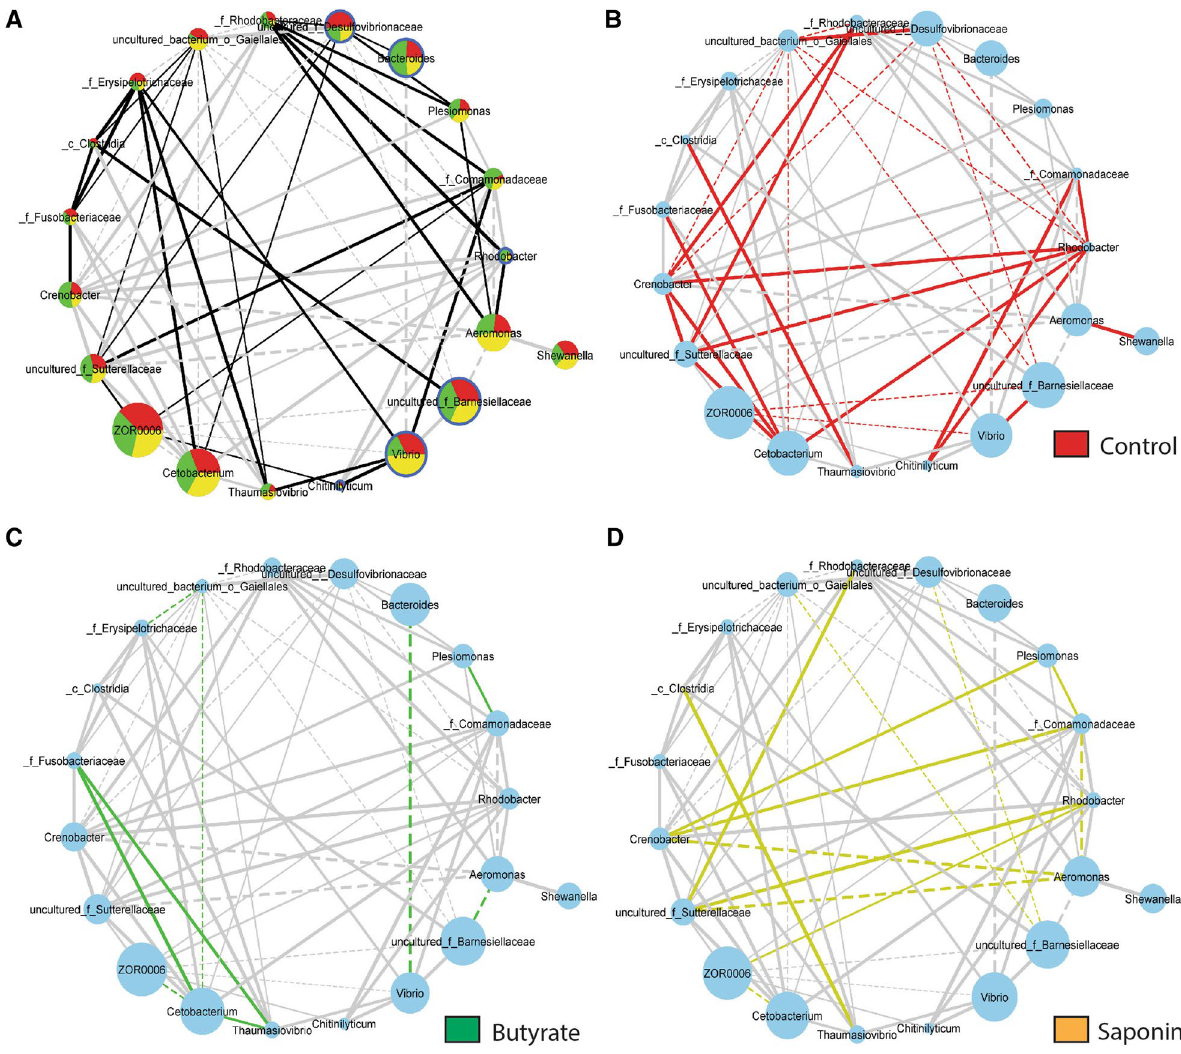
Fig. 5 Taxa connectivity: taxa included when prevalence is in 3/10 samples, abundance is 10 counts in 1 M and significance 0.1. The lines ≥ ≥ ≤ inform about the nature of the taxa interaction: the thickness of the lines represents the strength of the correlation (r-score value) and the shape of the lines represents the direction of the correlation, straight lines mean positive correlation (co-occurrence) whereas dashed lines mean negative correlation of the pairs of taxa (anti-occurrence). A Pairs of taxa co- and anti-occurring for all the diets: in black the interactions occurring in all three diets whereas in grey the interactions not occurring in all diets. Node size corresponds to average abundance of taxa for all diets at 68 dpf. B In red the interactions occurring in the control fed fish and not in the other two diets. Node size corresponds to average abundance of taxa for control diet at 68 dpf. C In green the interactions occurring in the butyrate fed fish and not in the other two diets. Node size corresponds to average abundance of taxa for butyrate diet at 68 dpf. D In yellow the interactions occurring in the saponin fed fish and not in the other two diets. Node size corresponds to average abundance of taxa for saponin diet at 68